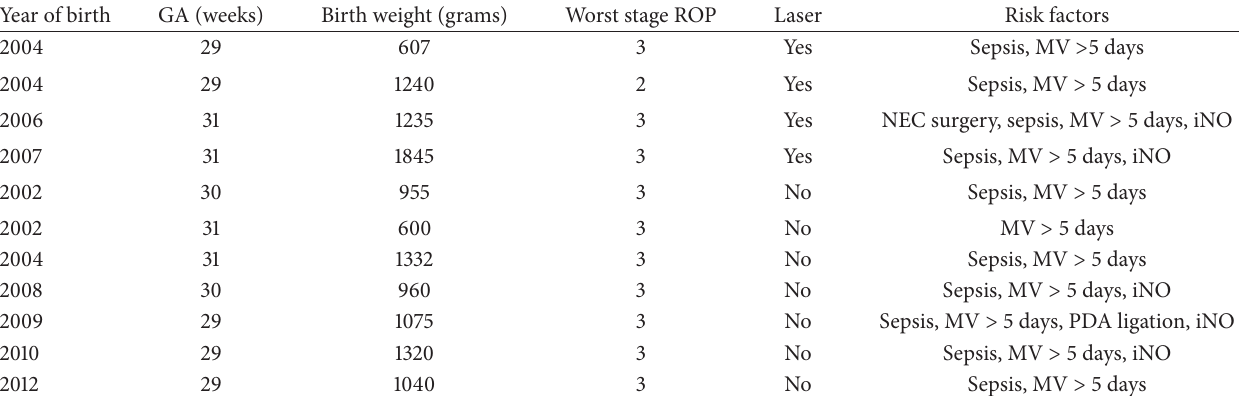
Table 4: Characteristics of infants ≥ 29 weeks gestation who developed severe retinopathy of prematurity